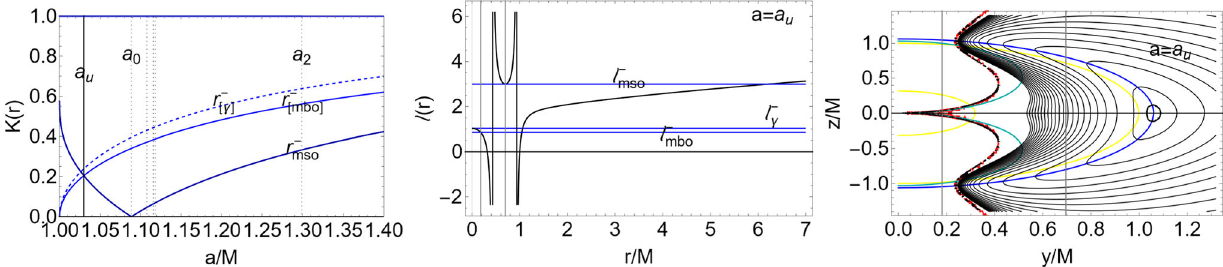
Fig. 8 Double co-rotating tori system with fluid specific angular momentum (cid:6) = (cid:6) − for a = 1 . 05 M . See Fig. 7